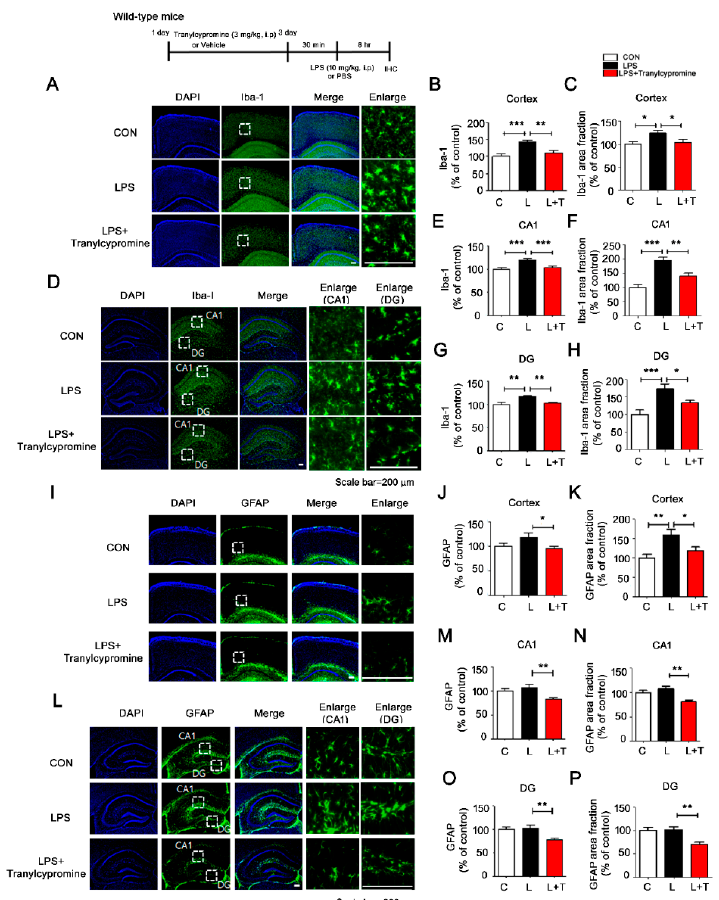
Figure 4. Tranylcypromine suppresses LPS-mediated microgliosis in wild-type mice. ( A,D , I , L )